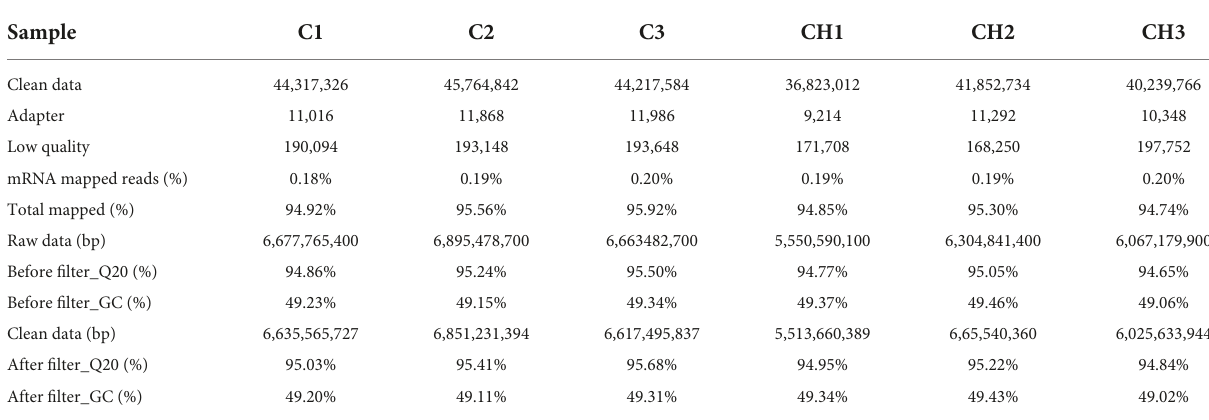
TABLE 1 Output statistics of sequencing reads and mapping